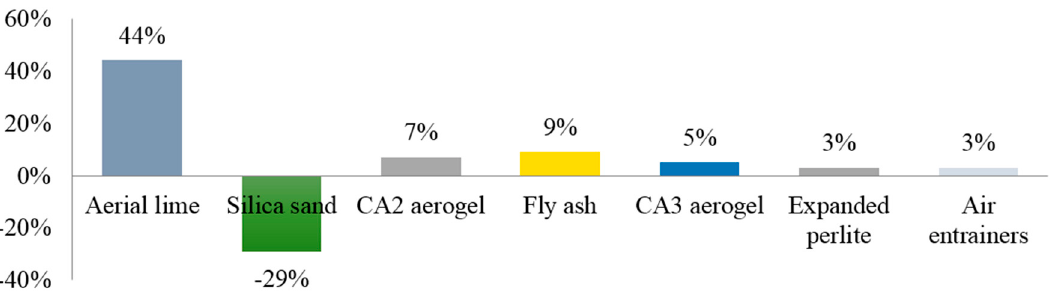
Figure 7. Relative importance of the components on the thermal conductivity of aerogel-based renders.